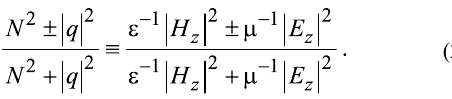
Figure S9.2–9.4 of Supporting Information File 1 provide further results from parametric studies.